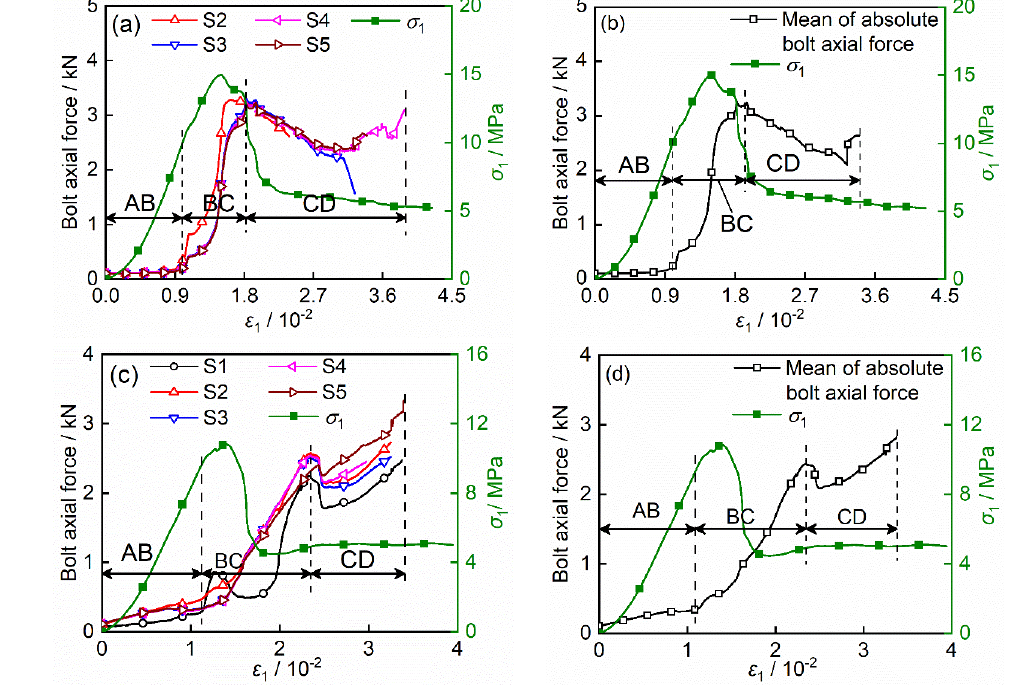
Figure 14. Evolution of bolt axial force: ( a , b ) Sample T-1; ( c , d ) Sample T-6.